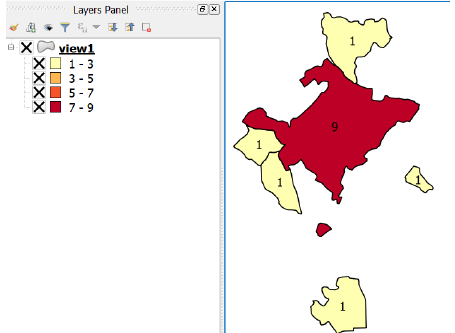
Figure 16. The ranking of the municipalities according to the number of retrieved GeoReports (within the first